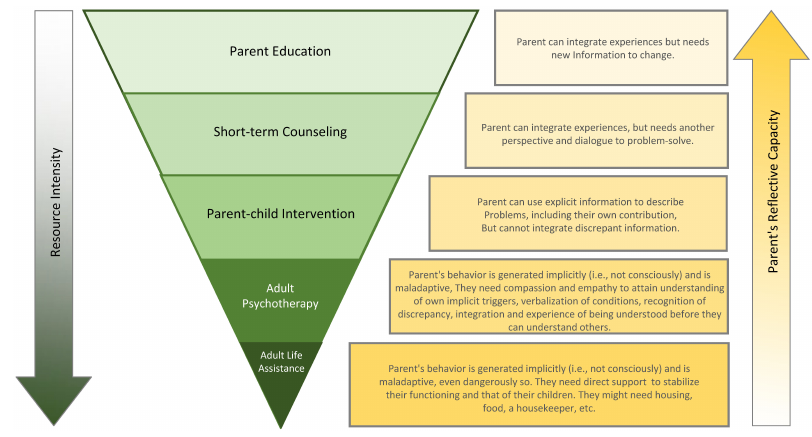
Figure A9. The DMM Gradient of